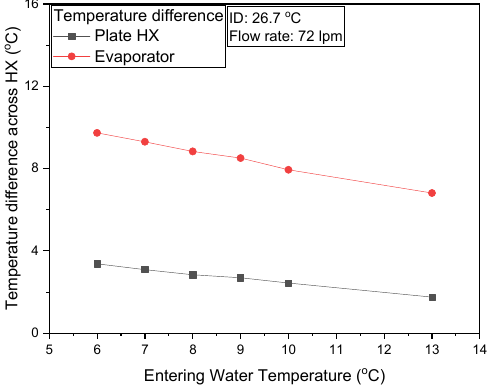
Figure 16. Temperature difference across HX in free-cooling mode.